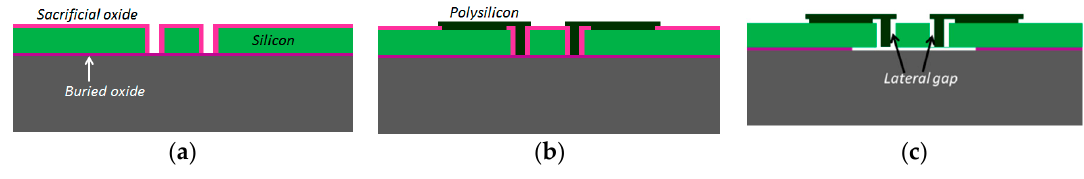
Figure 20. Fabrication of narrow gaps in a silicon-on-insulator-based process using polysilicon refilling of the gaps etched into the silicon device layer by Deep Reactive Ion Etching: ( a ) Conformal growth of sacrificial oxide to define lateral gaps; ( b ) Growth, etch back and patterning of polysilicon electrodes; ( c ) Release of silicon structure after removal of sacrificial oxide.